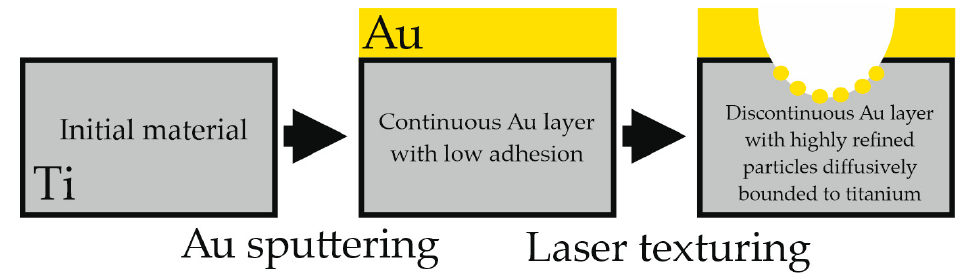
Figure 2. Experiment scheme.